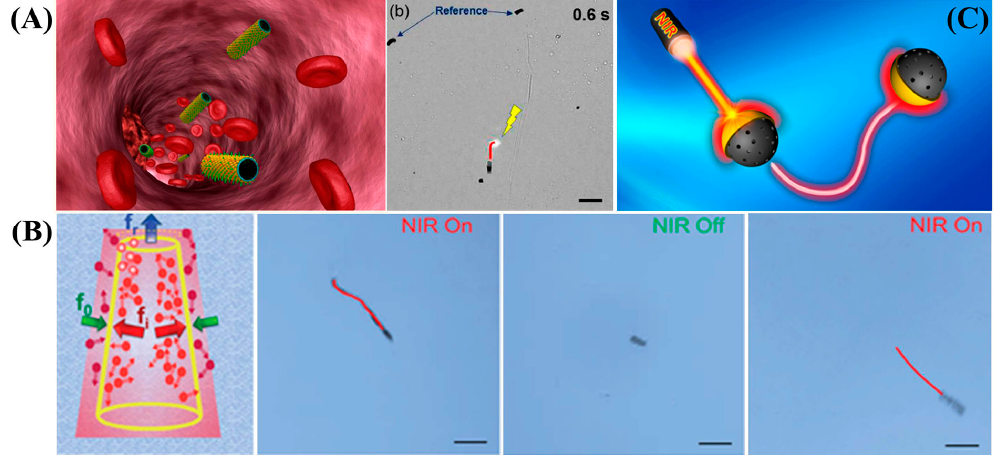
Figure 9. NIR light-driven MNMs. ( A ) NIR-induced launch of a microengine in 0.1% ( v / v ) H 2 O 2 solution. Reproduced with permission [91]. Copyright 2014, American Chemical Society; ( B ) Schematic mechanism of NIR-driven rockets (Small arrows represent the inner and outer thermophoretic forces, and the large arrow indicates the direction of the resultant force) and time-lapse images of NIR controllable launch, stop, and restarted movement of the rocket. Reproduced with permission [92]. Copyright 2015, Wiley-VCH; ( C ) Schematic of NIR-driven Janus